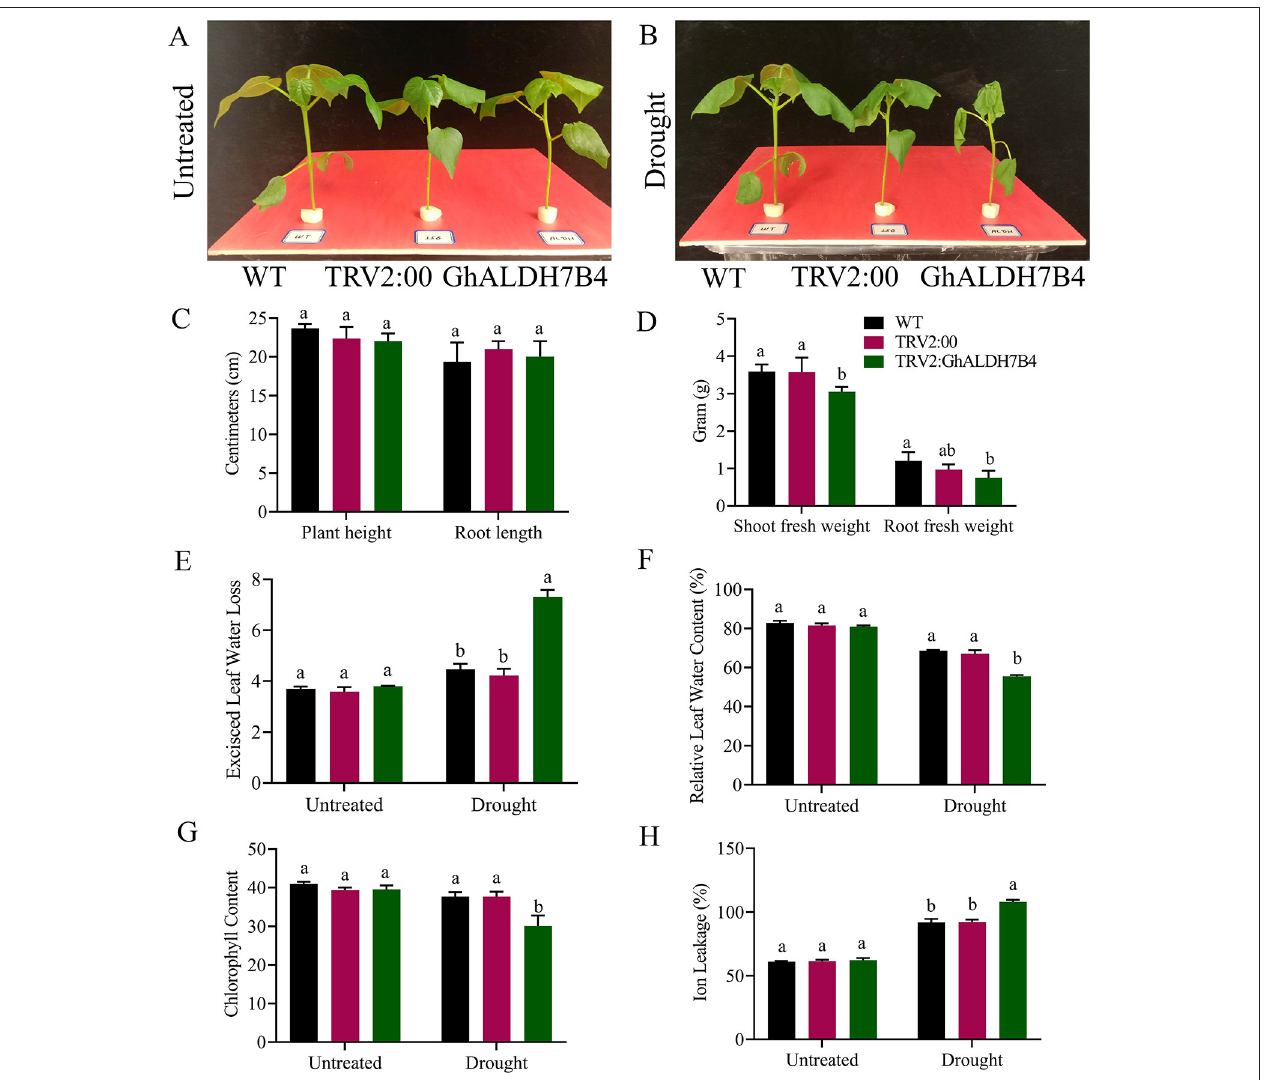
FIGURE 9 | Morphological and physiological trait evaluation. (A) Illustrative pictures of wildtype, positive control, and silenced seedlings before stress exposure. (B) Illustrative pictures of wildtype, positive control, and silenced seedlings after stress exposure. (C) Plant height and root length. (D) Shoot fresh weight and root fresh weight. (E) Excised leaf water loss. (F) Relative water content, (G) chlorophyll content in leaves, (H) cell membrane stability. The error bars reflect the standard error (SE). Using the Least Significant Difference (LSD), means on the same graph, with the same letter are not significantly different at the 5% probability level,